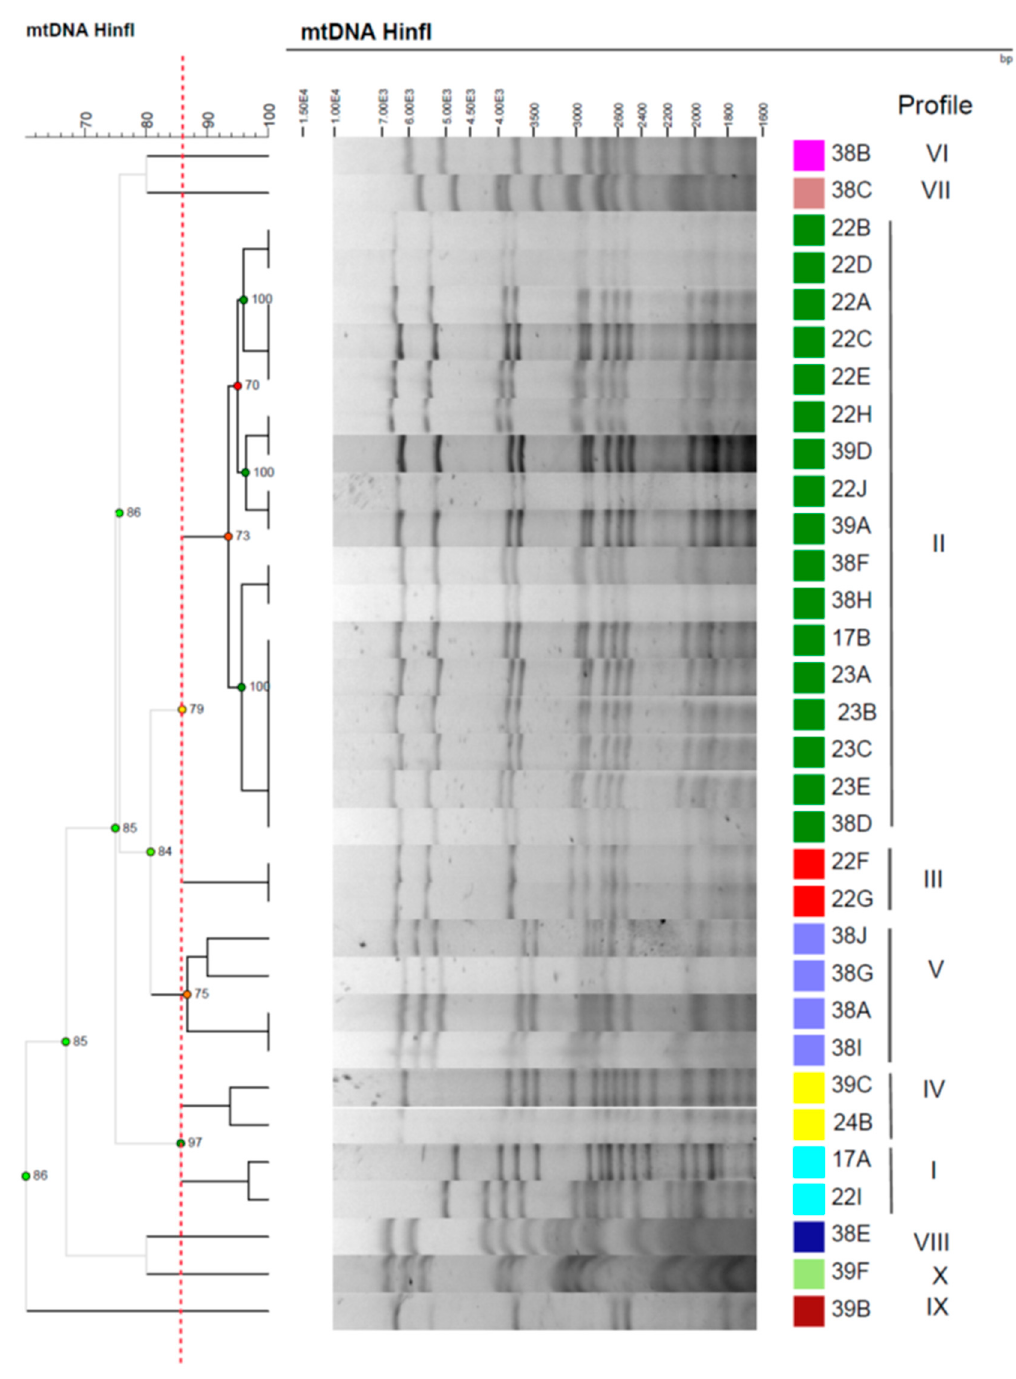
Figure 1. Dendrogram based on the similarities of the mDNA HinfI restriction profiles built using Pearson’s product-moment correlation coefficient and the unweighted pair group method with arithmetic mean (UPGMA). Cut-off level set at 86%